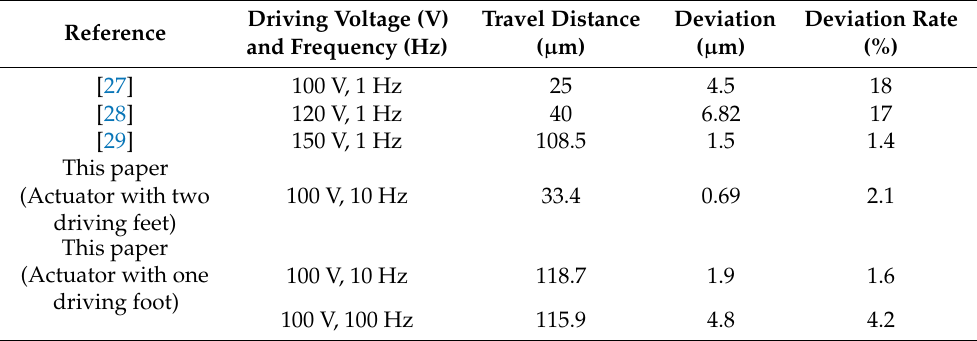
Table 6. Comparison in deviation and deviation rate between some previously proposed actuators and the actuators developed in this